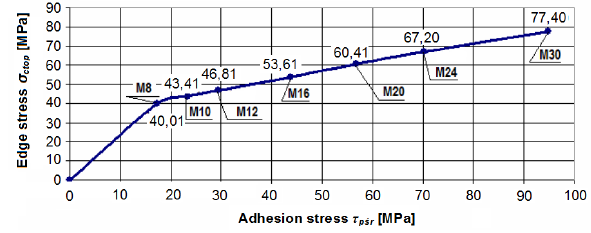
Figure 6: Dependency edge stress – adhesion stress for M8 ÷ M30 anchors in the stairwell